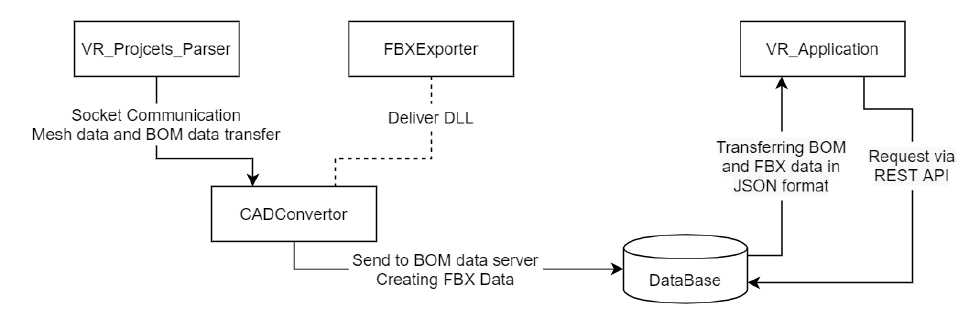
Figure 11. VR engineering project